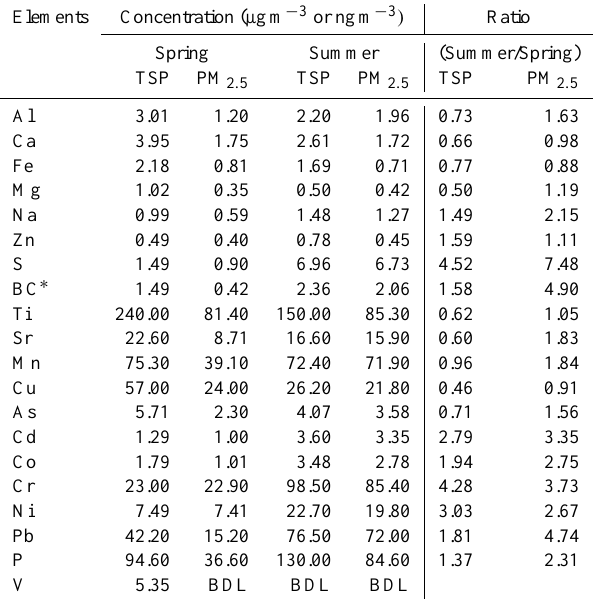
Table 6. Concentrations (µgm − 3 ) of elements in PM 2 . 5 and TSP and the corresponding ratios of summer/spring at MT. Elements